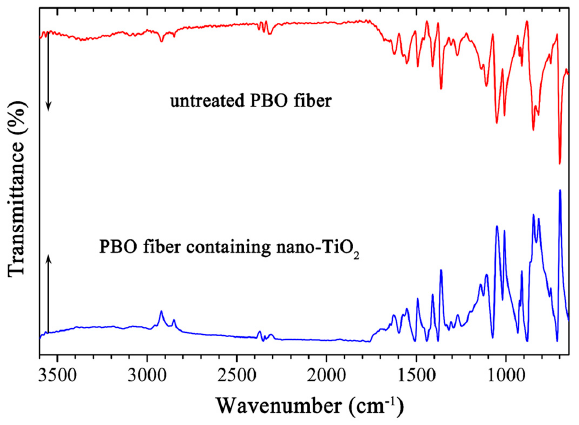
Figure 6. FTIR spectra of untreated PBO fiber and PBO fiber containing nano-TiO 2.